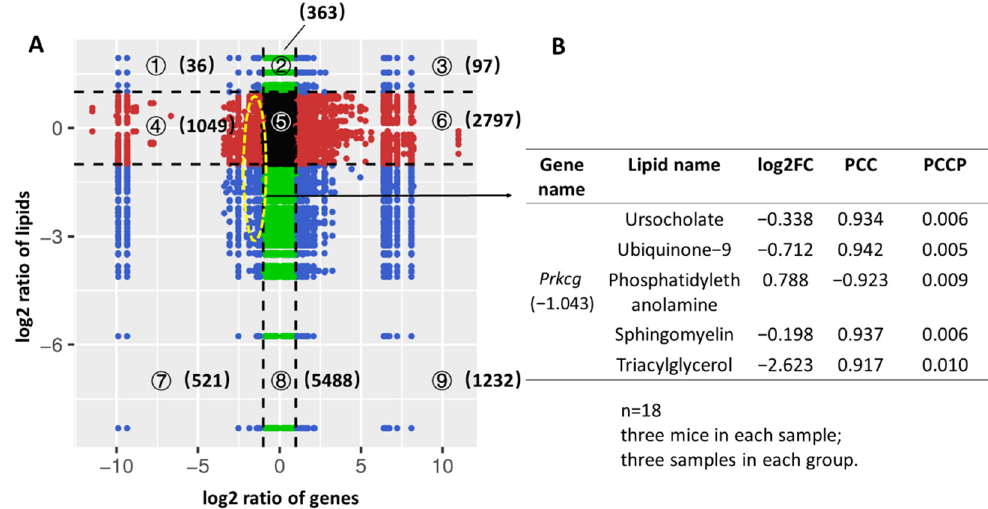
Figure 6. Latent associations among genes and lipids. ( A ) Quadrant diagram represents the association of genes and lipids. The x -axis and y -axis represent the log2 ratio of genes and the log2 ratio of lipids, respectively; black dotted lines represent the threshold of significant difference; black dots represent that genes and lipids were not significantly changed; green dots represent that lipids were significantly changed and genes were not significantly changed; red dots represent that genes were significantly changed and lipids were not significantly changed; blue dots represent that genes and lipids were significantly changed. The number in brackets represents the number of dots; ( B ) lipids associated with Prkcg (|PCC| > 0.8).